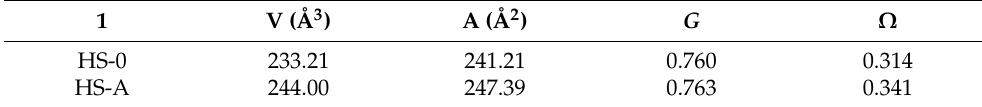
Table 2. Details of the two HSs generated for 1 (HS-0: main molecule; HS-A: molecule